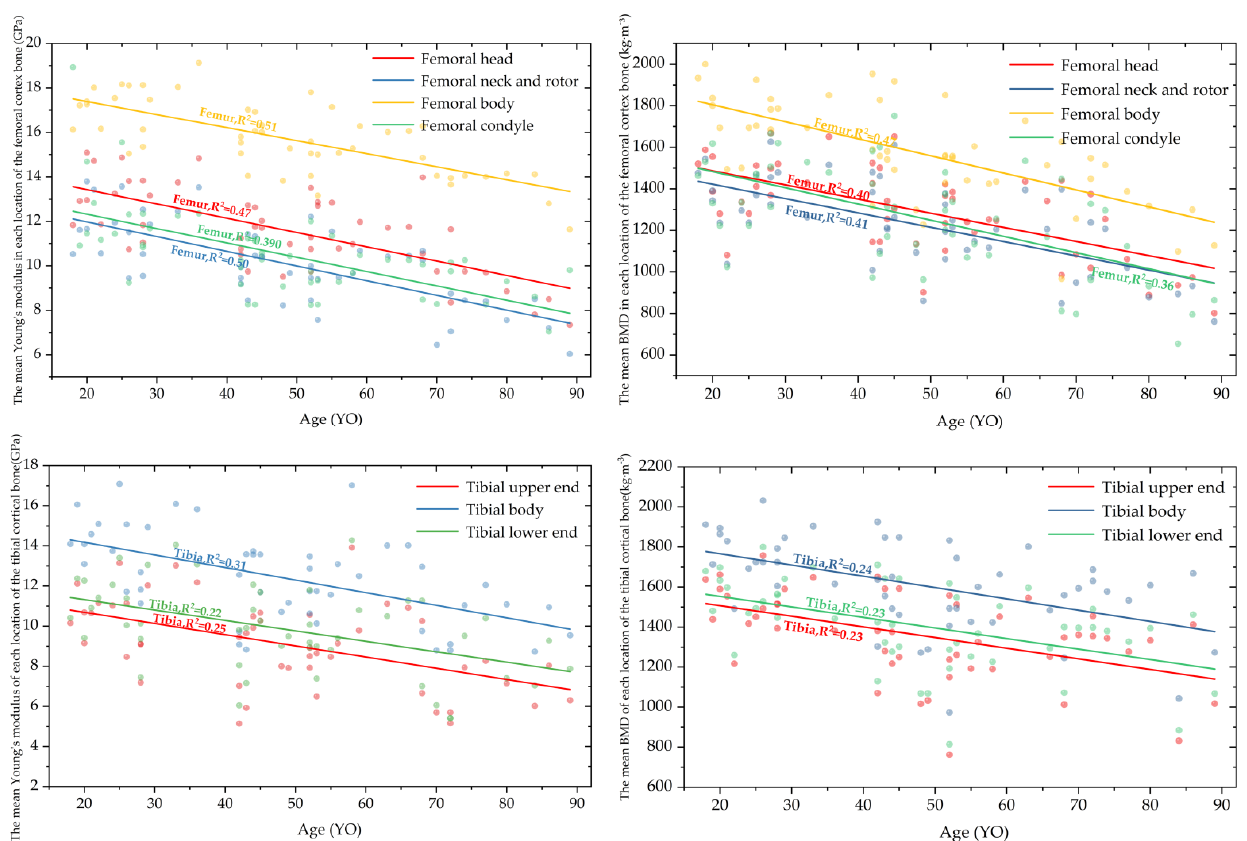
Figure A1. Comparison of Young’s modulus and BMD of cortical bone in different locations of femur and tibia. The ground color dot in the figure represent the true distribution of each sample, and the linear bar segments are the result of our linear fitting. Table A2. Material properties of the long bones of the lower limbs of seven Chinese